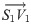
Directional derivatives along S1V1→
.